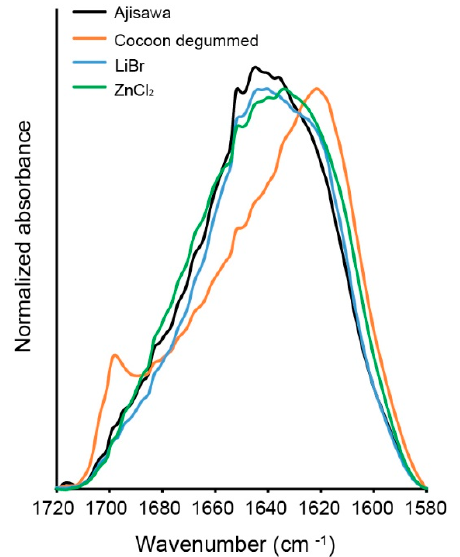
Figure 7. Baseline corrected ATR absorbance spectrum of the amide I band. Table 2. Comparison of main bands of ATR-FTIR spectra (cm − 1 ) of silk fibroin films.